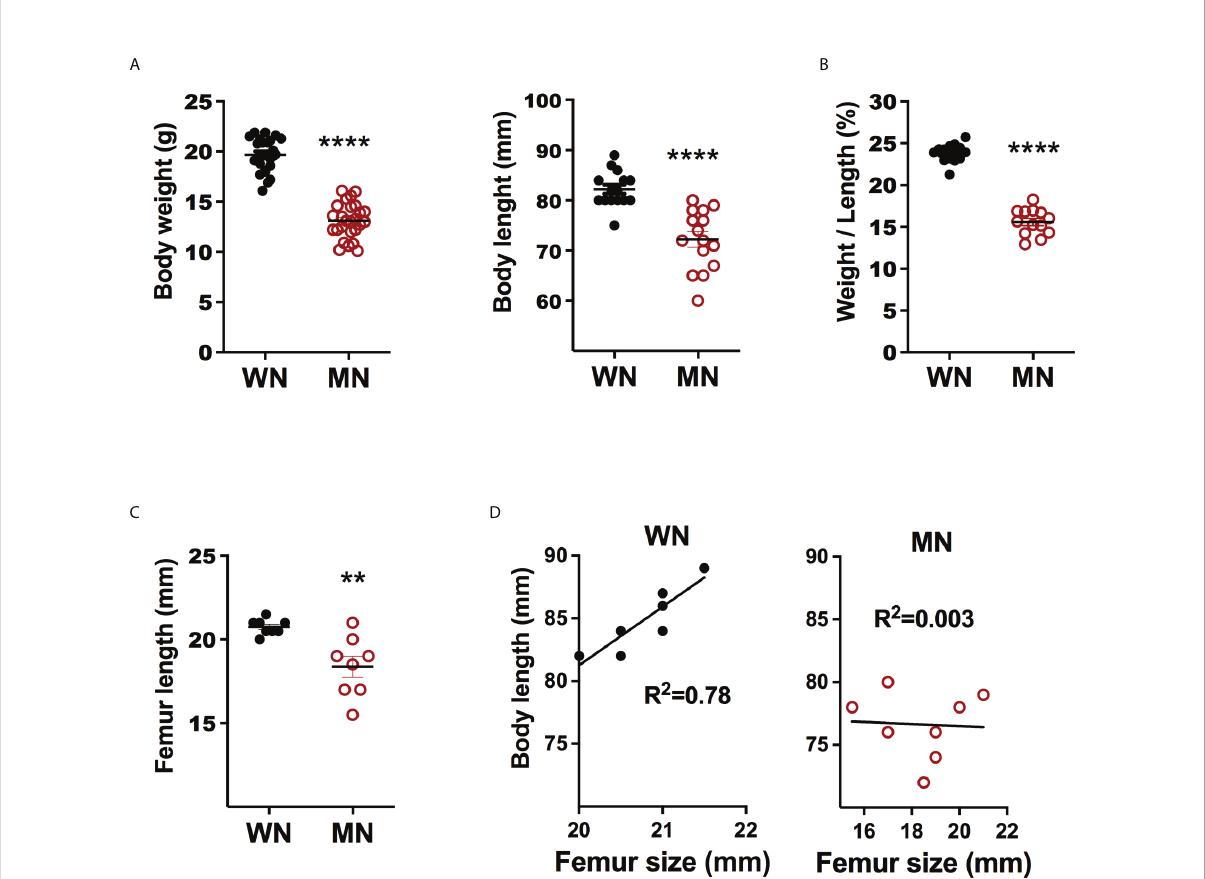
FIGURE 1 Body and bone metrics of control and malnourished mice. 3-week old BALB/c mice were placed on the isocaloric control and nutrient- de fi cient diets for 28 days and body weight and body and femur length measured. (A) Body weight (g) and body length (mm) of naïve control (well-nourished; WM) and malnourished (MN) mice. Data pooled of 4 different experiments with >5 mice per group in each experiment. (B) Ratio of body weight (g) to body length (mm) (W/L) in naive well-nourished (WN) and malnourished mice (MN). Data pooled of 2 experiments with 8 mice per group. (C) Femur length (mm) in WN and MN mice. Data are from a single experiment representative of 2 experiments with 8 mice per group, (D) Correlation of body length vs. femur length in WN and MN mice. Data are from a single experiment representative of 2 experiments with 8 mice per group. **p<0.01,